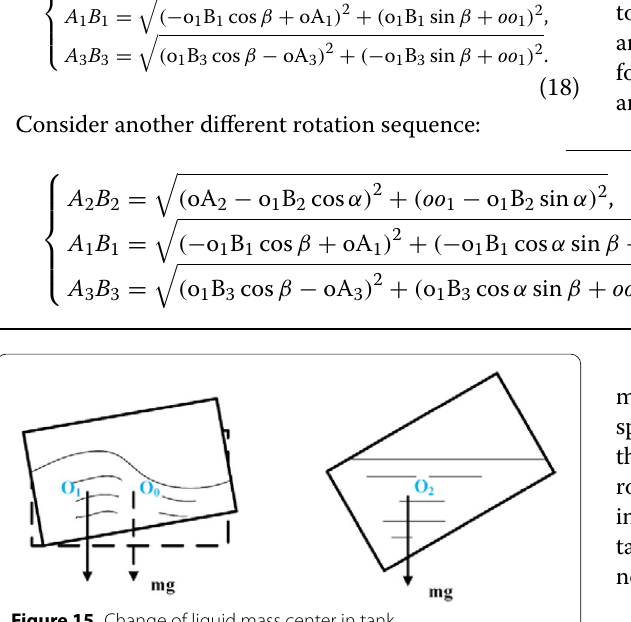
Figure 15 Change of liquid mass center in